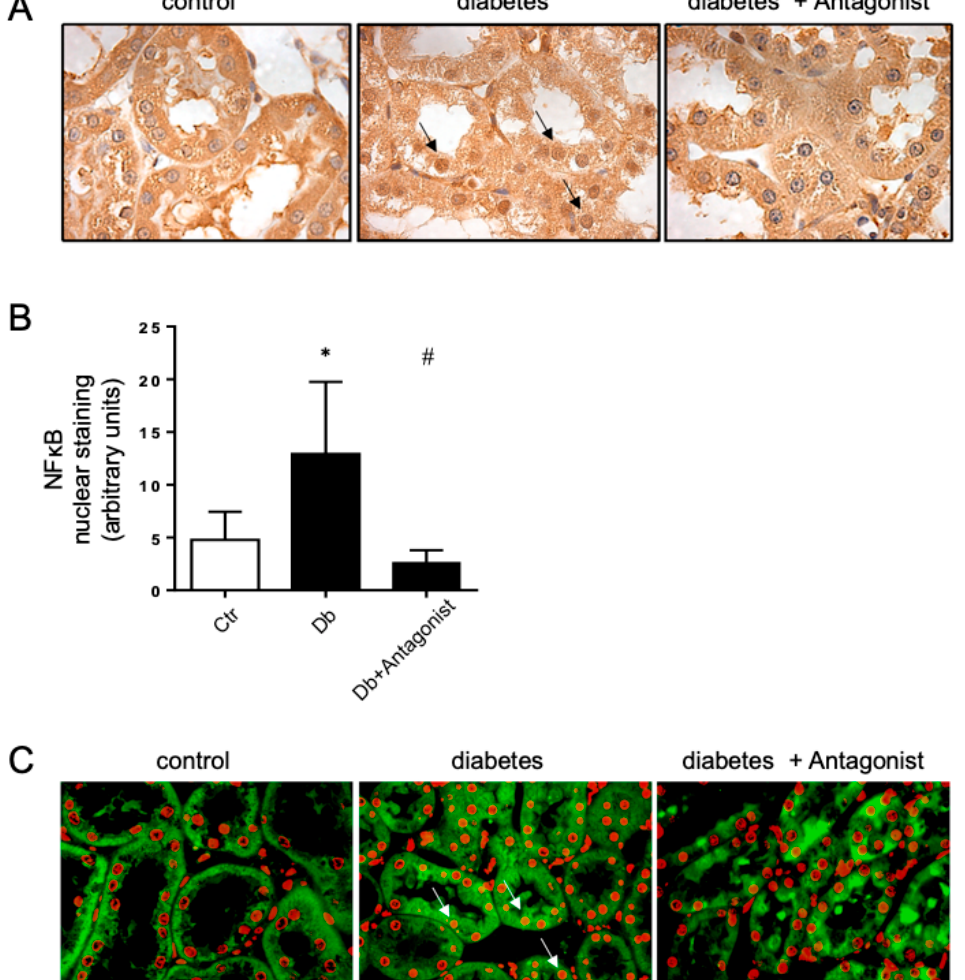
1 activity. While using immunohistochemical analysis, we observed that diabetic rats present an